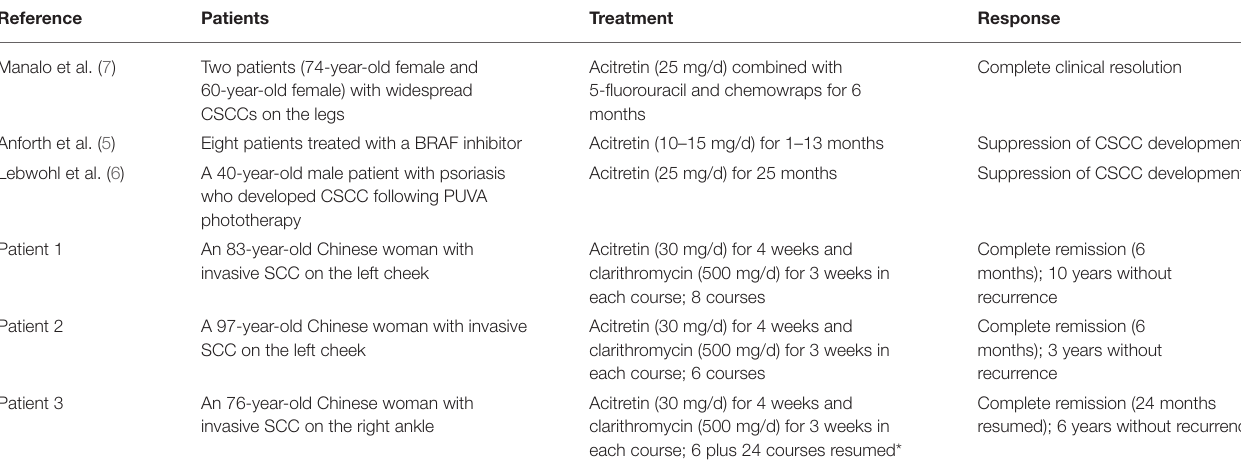
TABLE 1 | Summary of publications reporting cases and our cases of cutaneous squamous cell carcinoma (CSCC) treated with